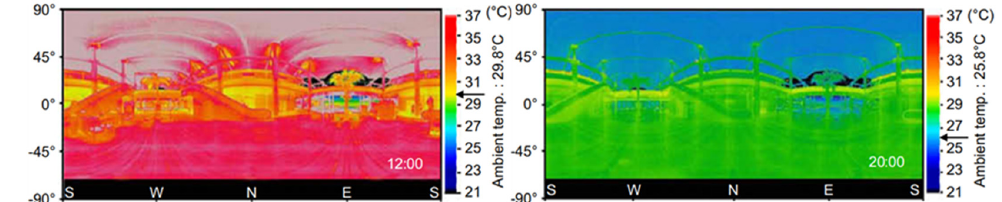
Figure 17. Thermography of the environment inside the structure [100].